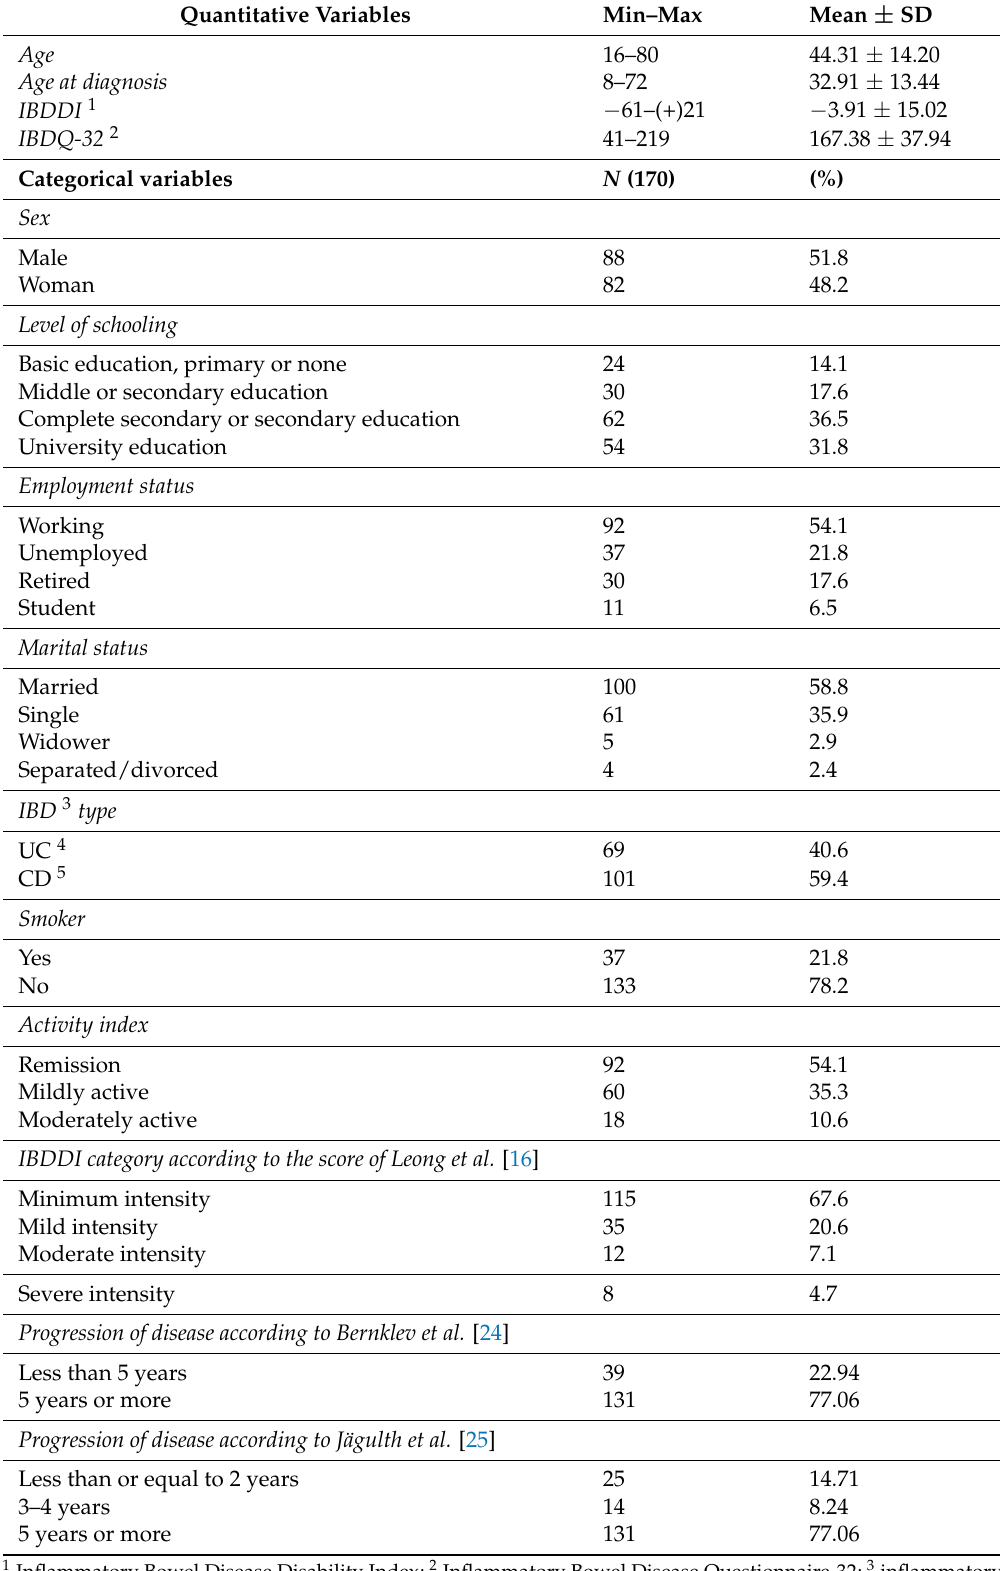
Table 1. Sociodemographic and clinical